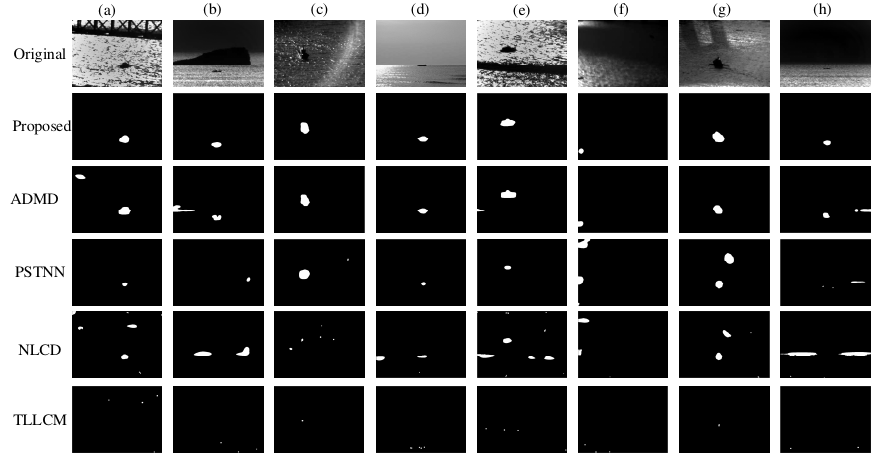
Figure 20. ( a – h ) Comparison of detection results of six detection algorithms. The Gaussian difference, local minimum detection and multi-scale construction in the VAM applied in this paper are all based on a convolution calculation. When N represents the total number of image pixels and p represents the local neighborhood scale, the time complexity of the proposed algorithm is O( p 2 N ). The time complexity of other methods has been calculated in their respective literatures. The time complexity and time consumption of all methods are finally shown in Table 3, from which we can find that the time complexity of this algorithm is the lowest. We simplified the traditional VAM, mainly reflected